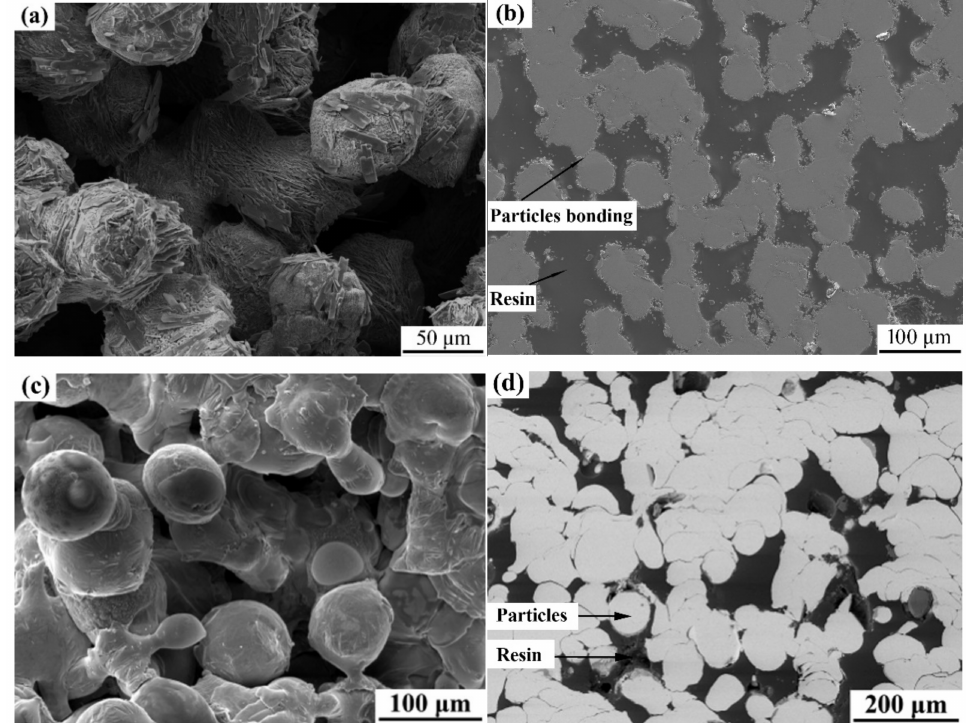
Figure 3. Typical surface morphology and cross-sectional microstructure of ( a , b ) porous Mo and ( c , d ) 316L deposits obtained by flame spraying with an acetylene flow rate of 150 L/h and a spray distance of 40